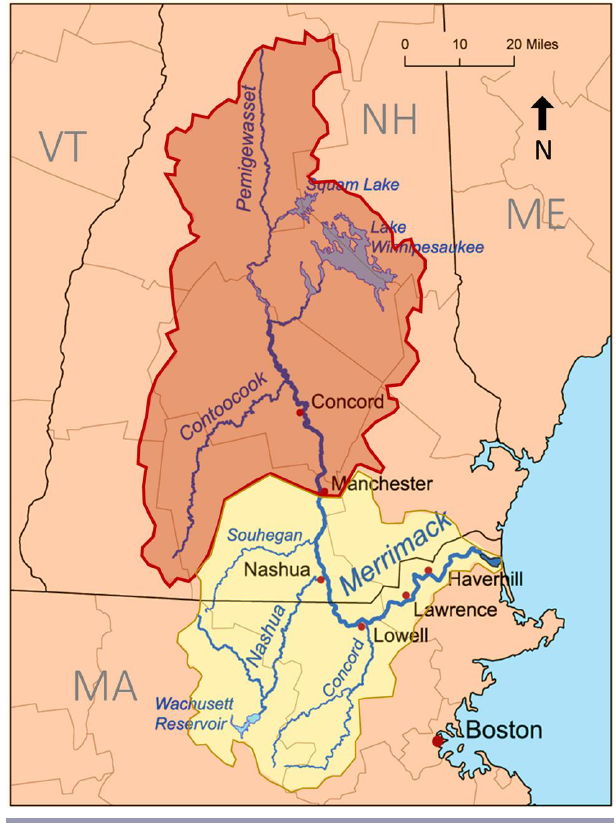
Fig. 1. Map of the Merrimack River watershed, with the area of study indicated by darker shading. Licensed under the Creative Commons Attribution-Share Alike 2.5 Generic